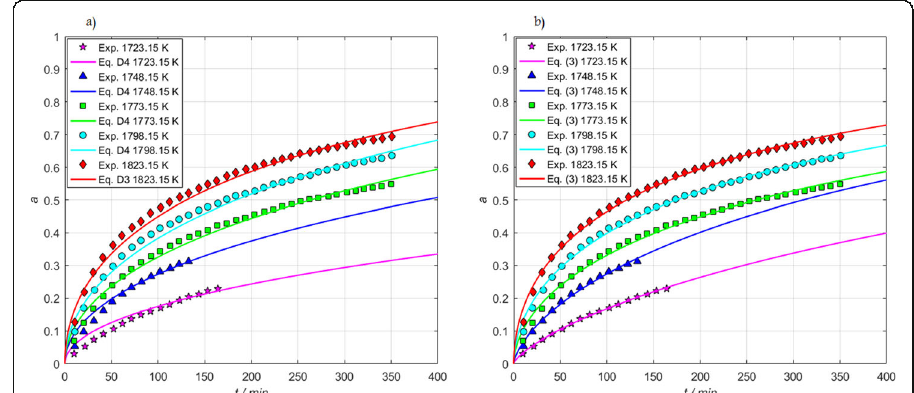
different temperatures